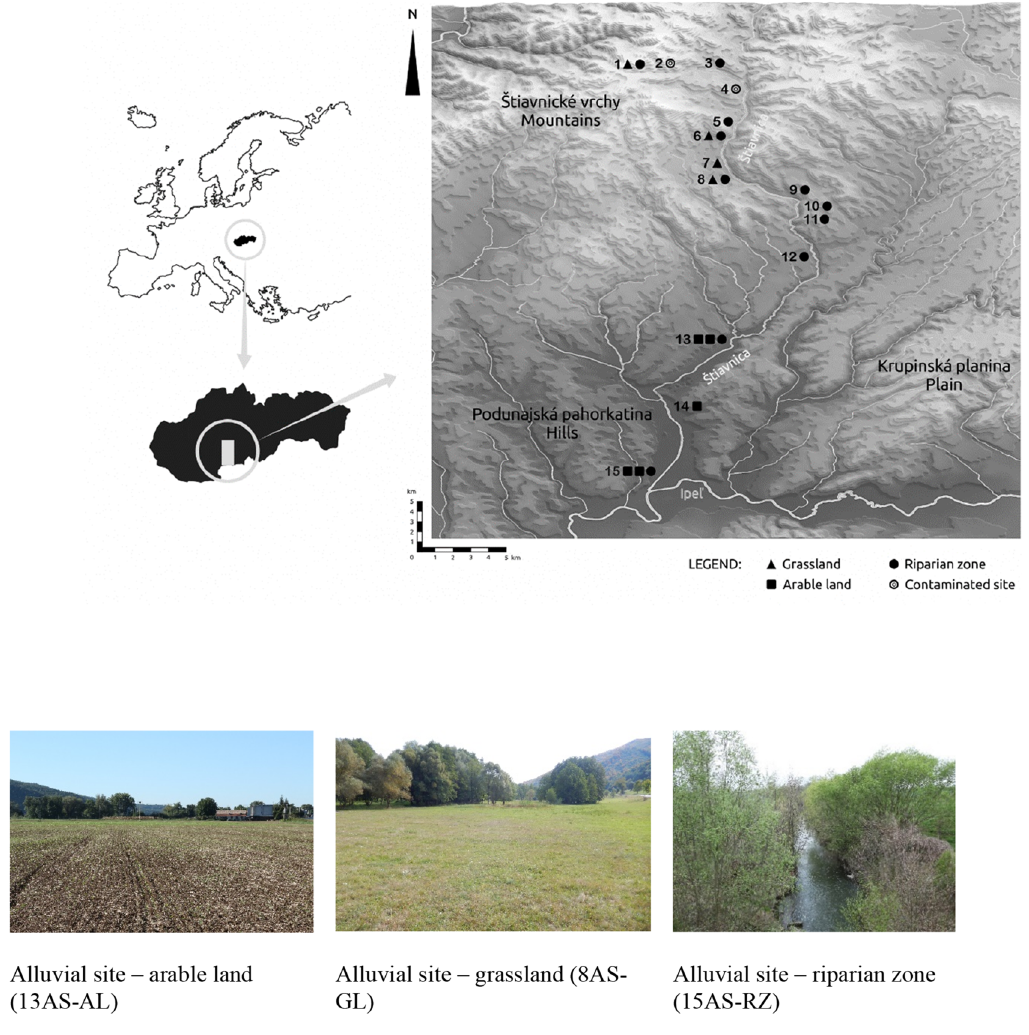
Figure 1. Isometric map of the sampling points and photos from selected study sites (photos R. Kanianska). The map was generated using 3D Map Generator, ver. 1.5, https:// www. 3d- map- gener ator. com/ 3d- map- gener ator- terra